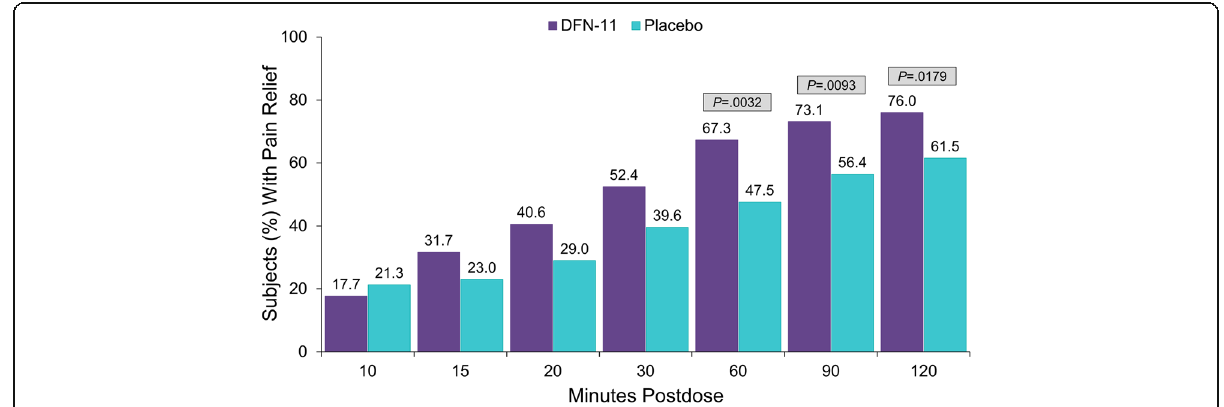
Fig. 3 Proportion of subjects with pain relief through 2 h